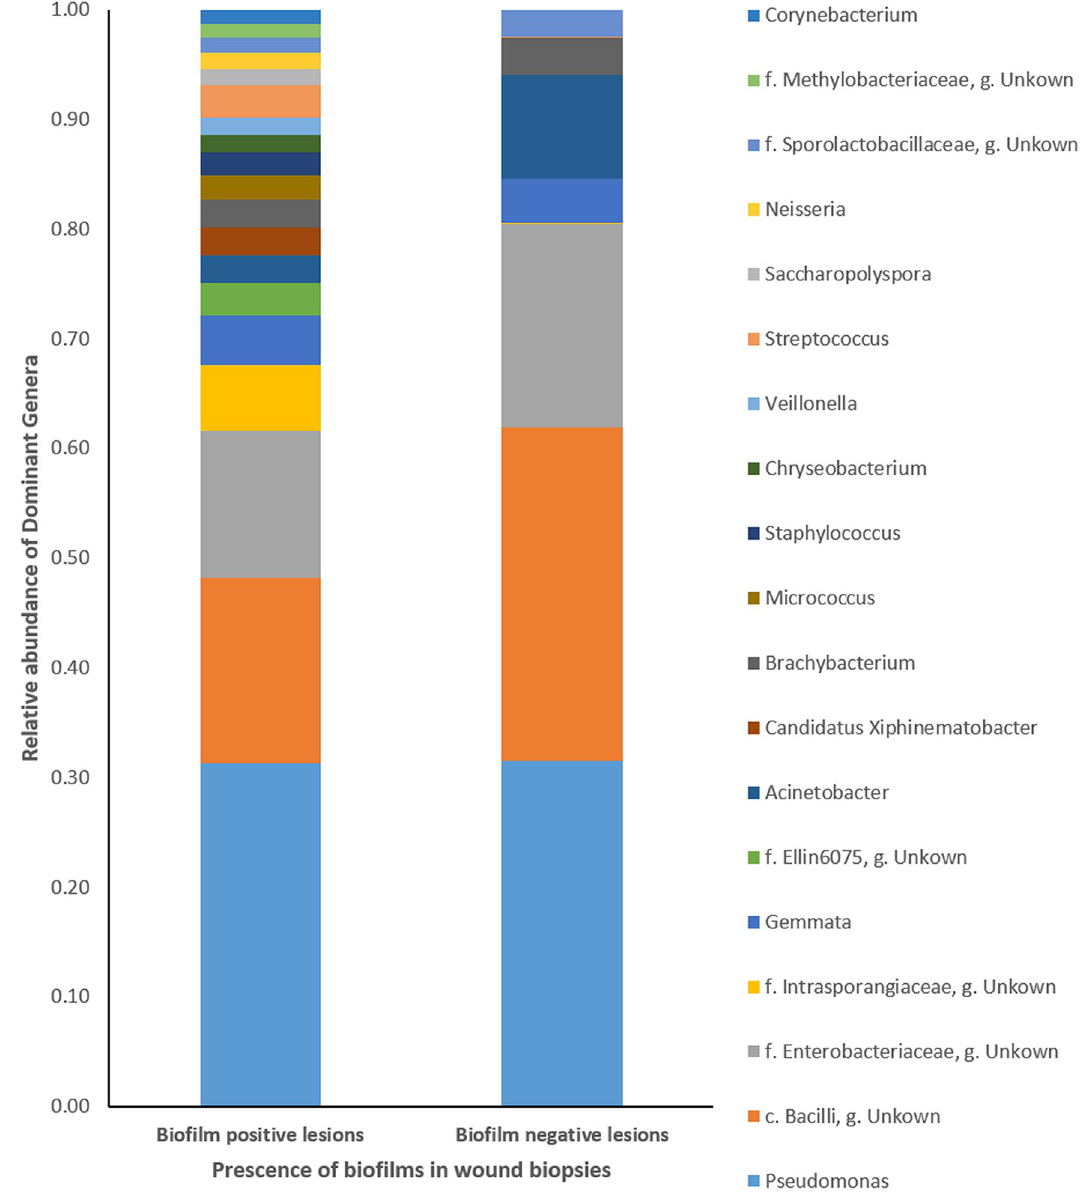
Figure 5. Relative abundance of genera (genera with > 1% abundance considered) in biofilm positive and negative wound biopsy samples. f: Family; o: Order; g: Genus. (Figure generated by Microsoft Excel